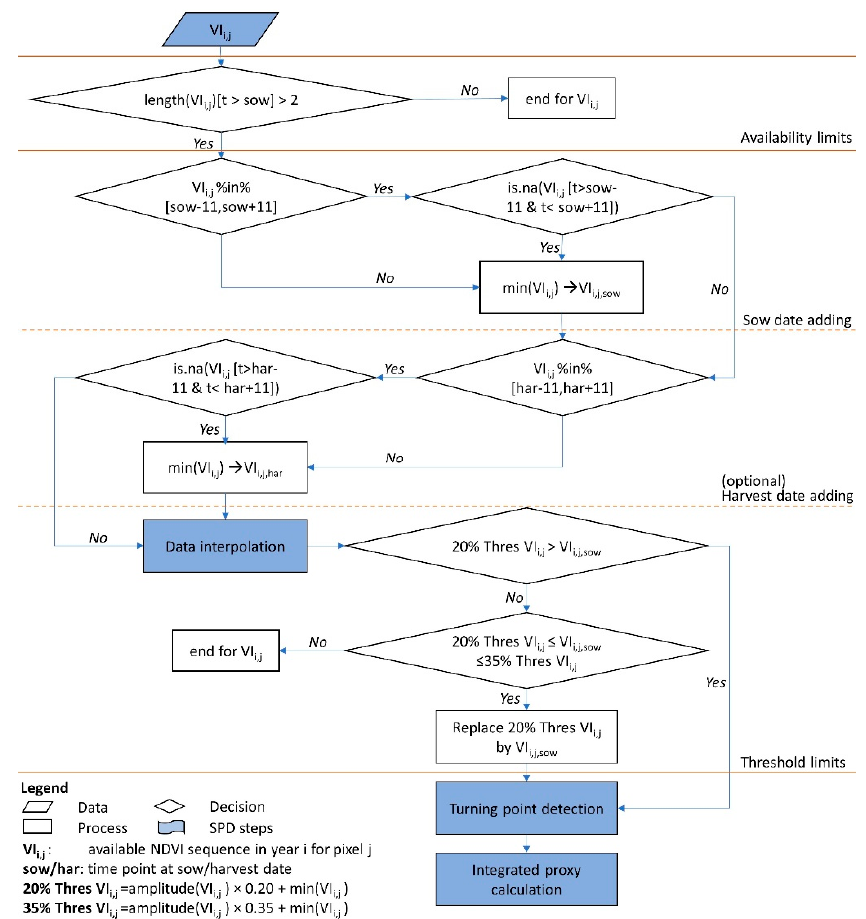
Figure 3. The workflow to conditionally include SD/BOS NDVI in statistical curve fitting. The brown horizontal lines divide the workflow into four sections: availability limits, sow date adding, harvest date adding (optional, dashed line), and threshold limits. ‘Sow date’ refers to either actual sow date (+SD) or rainfall-based break of season date (+BOS).